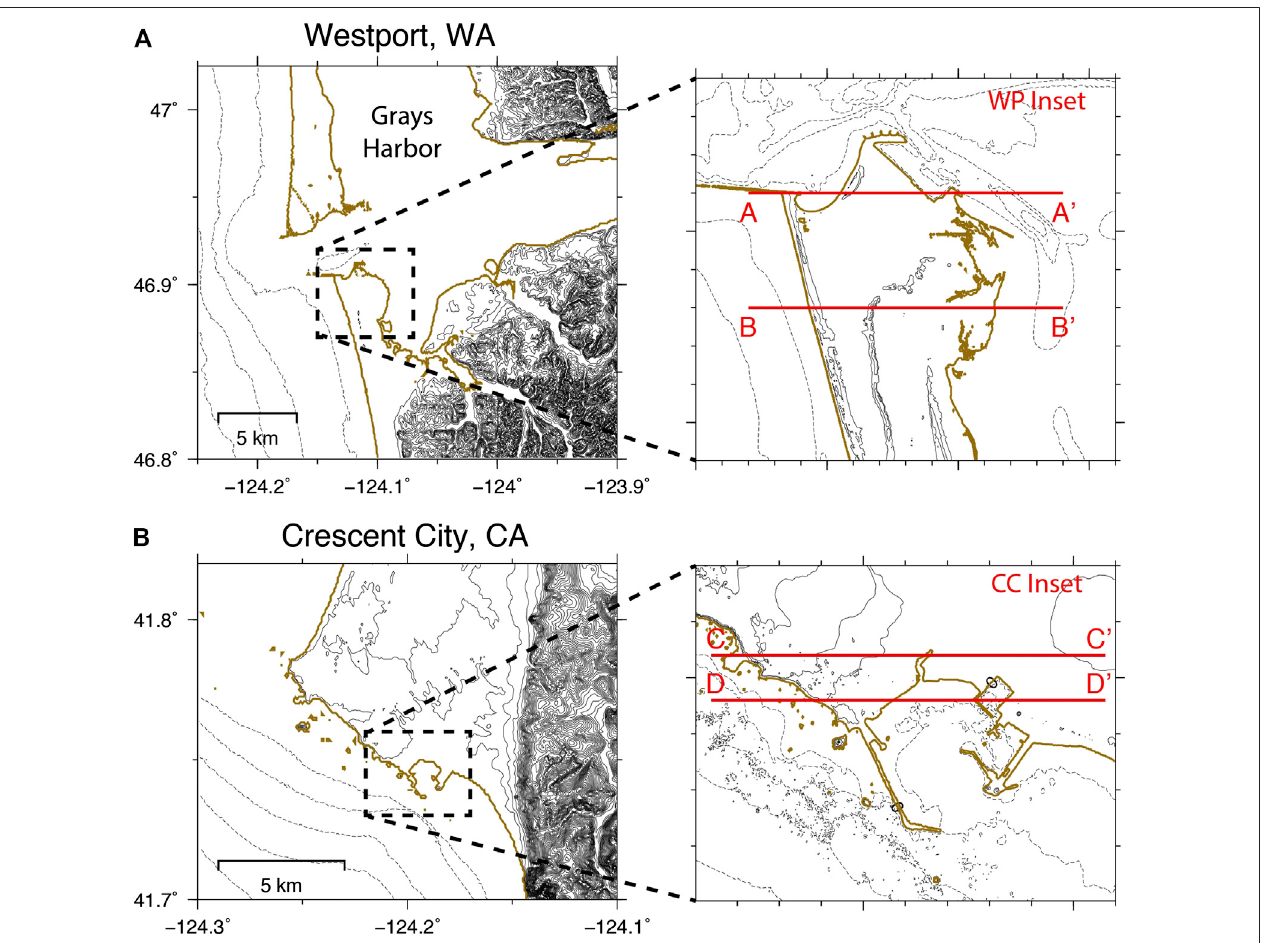
FIGURE 3 | Communities of interest in this study. (A) Regional and inset view of Westport, WA and two representative cross sections shown in Section 7 . (B) Regional and inset view of Crescent City, CA with two representative cross sections. Both regional views have a bathymetric (dashed) and topographic (solid) contour interval of 10 m. Inset fi gures use a contour interval of 5 m. The coastline is differentiated with a bolded brown line.